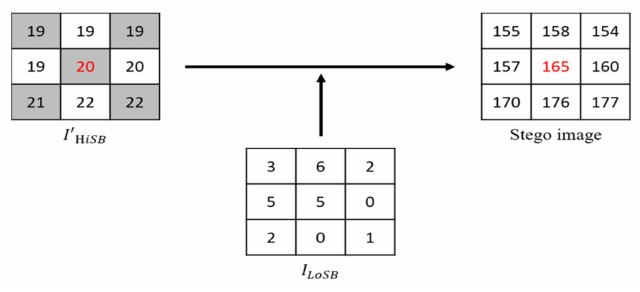
Figure 4. Stego image I (cid:48) after